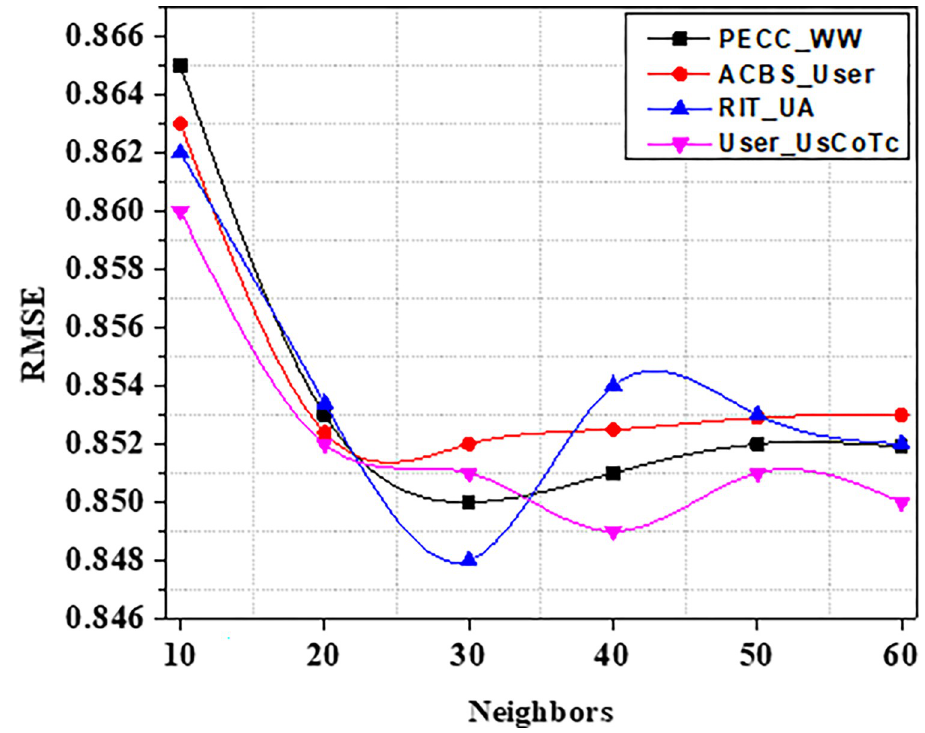
Fig 12. RMSE with varied neighbors range.